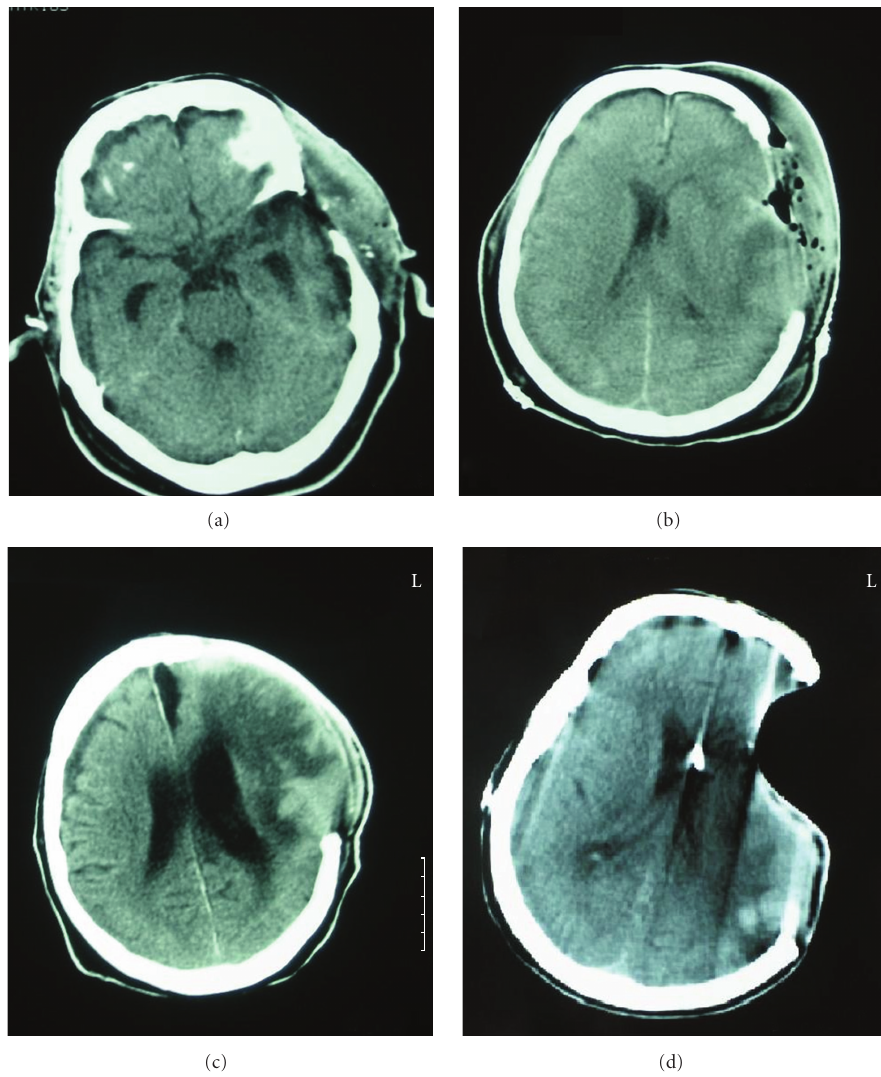
Figure 3: Satisfactory removal of an acute subdural hematoma (a), but the followup scan revealed ventricular dilation with a right subdural e ff usion and widening of the interhemispheric fissure (b) and (c), which were successfully treated with a V-P